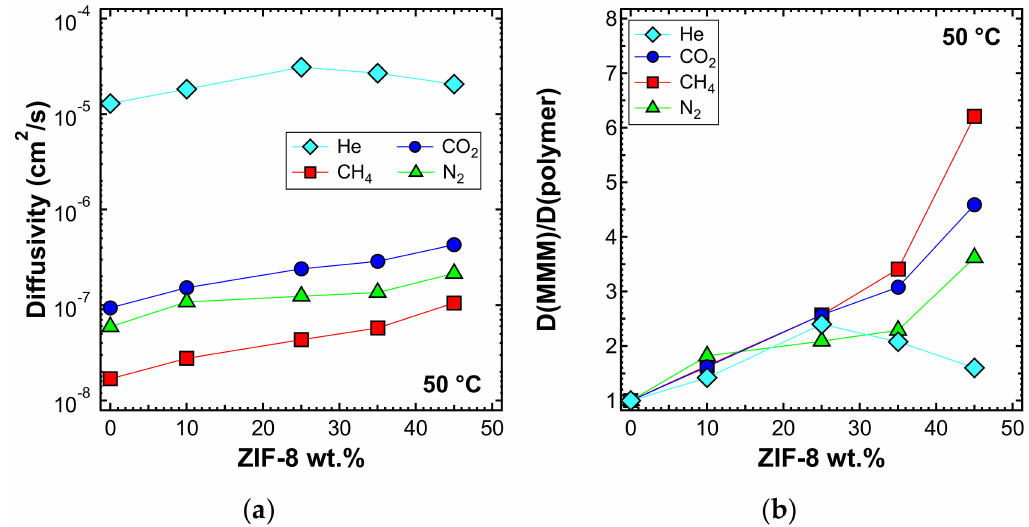
Figure 18. ( a ) Di ff usivity and ( b ) relative di ff usivity increase of various gases at 50 ◦ C in ZIF-8 / PPO MMMs, estimated with the time-lag method.